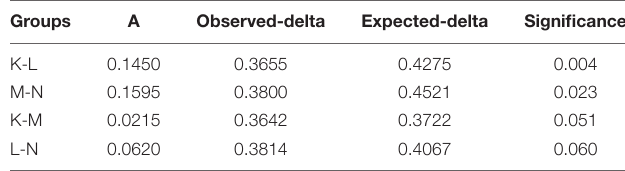
TABLE 3 | ANOSIM analysis between the four groups of European mouflon and blue sheep.